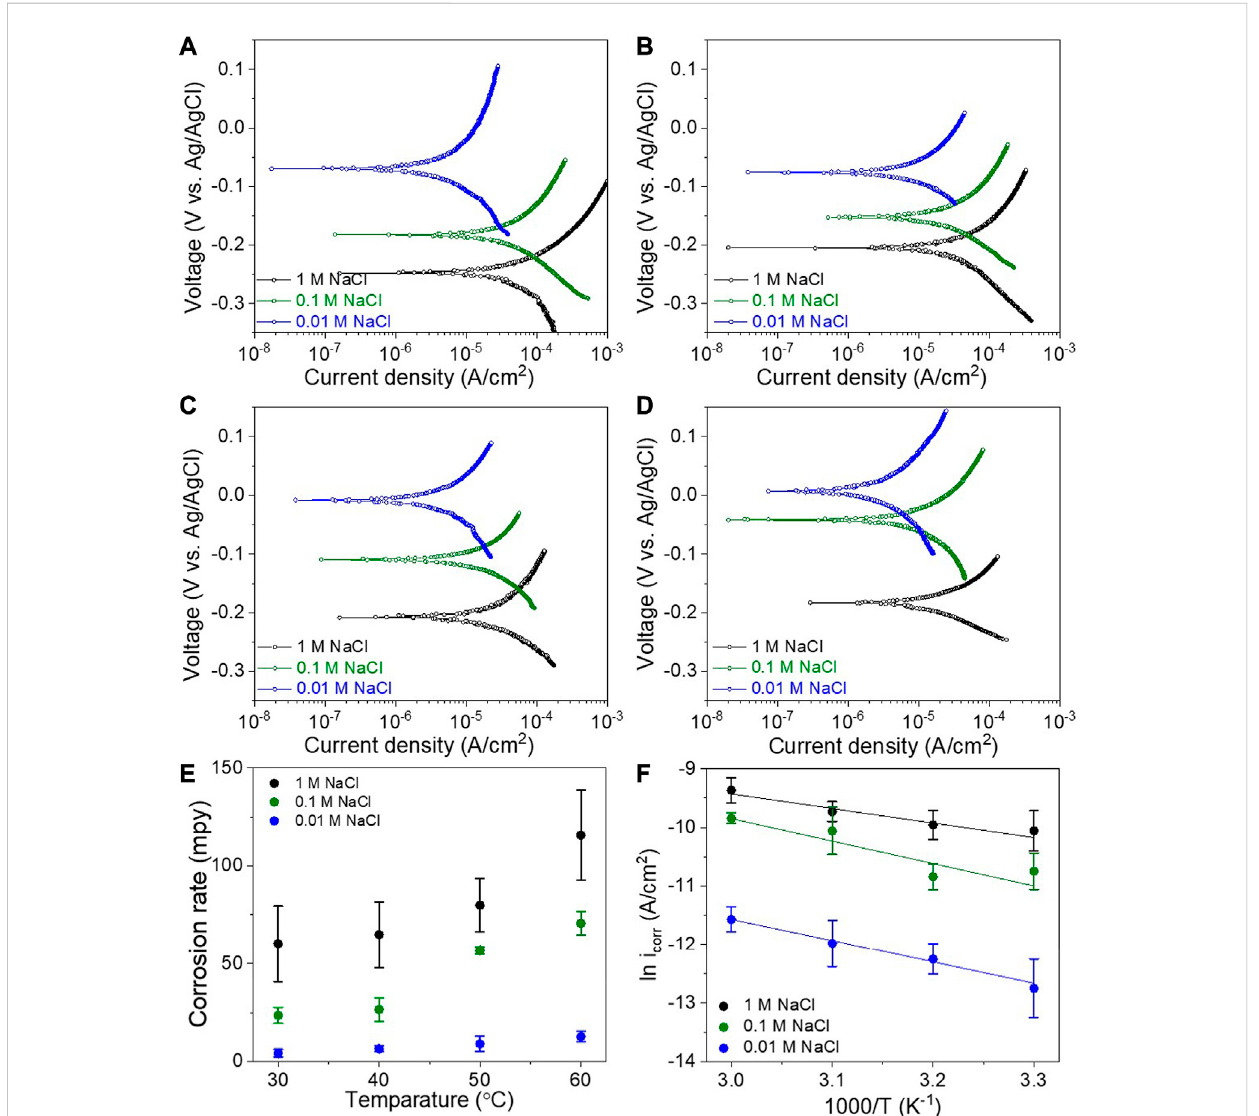
FIGURE 2 Potentiodynamic polarization curves of SCCY in various concentrations of 1, 0.1, and 0.01 M NaCl solution at (A) 60 ° C, (B) 50 ° C, (C) 40 ° C, and (D) 30 ° C, (E) variation of the corrosion rate with the NaCl concentration and temperature of the electrolyte, and (F) Arrhenius plots of ln icorr depending on 1000/T with the NaCl